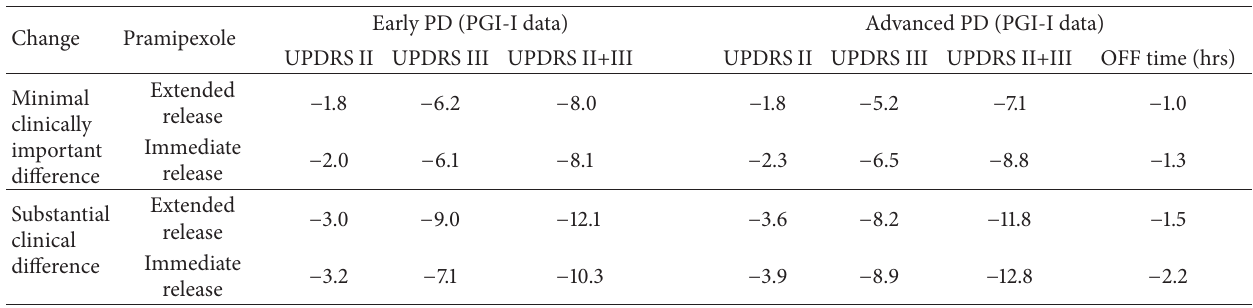
Table 4: The minimal clinically important difference and the substantial clinical difference in UPDRS scores in early PD and advanced PD. Change Pramipexole